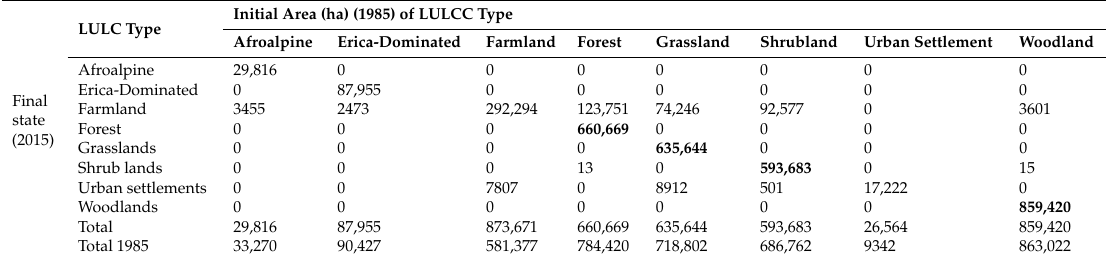
Table 5. Change matrix of LULCC types between 1985 and 2015.